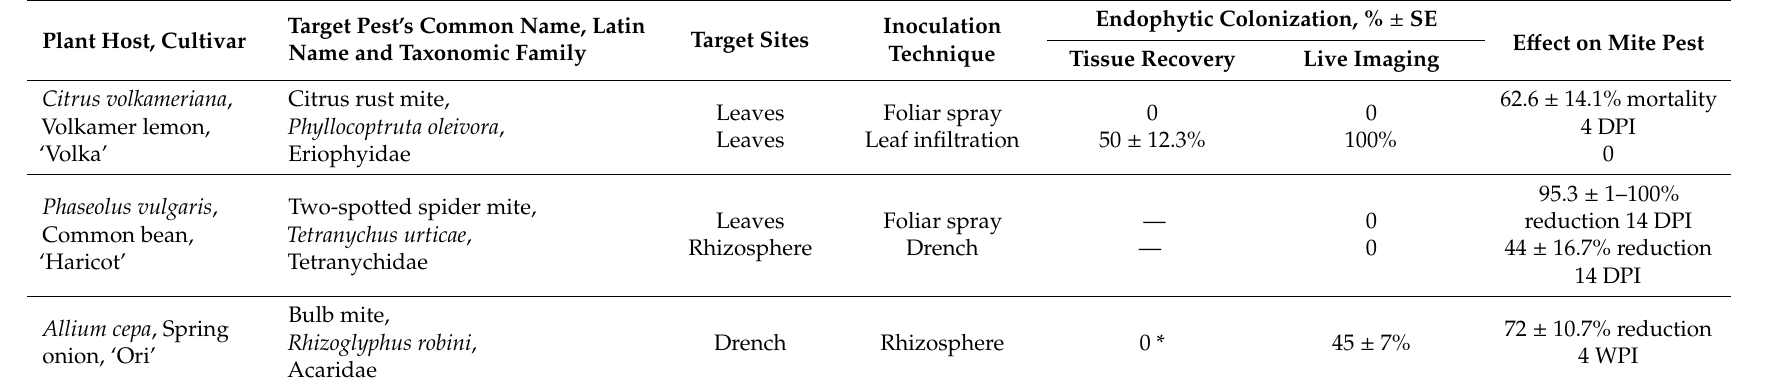
Table 1. Plant-host target sites, inoculation techniques, endophytic colonization (average % ± SE), and e ff ects on mite mortality and population reduction